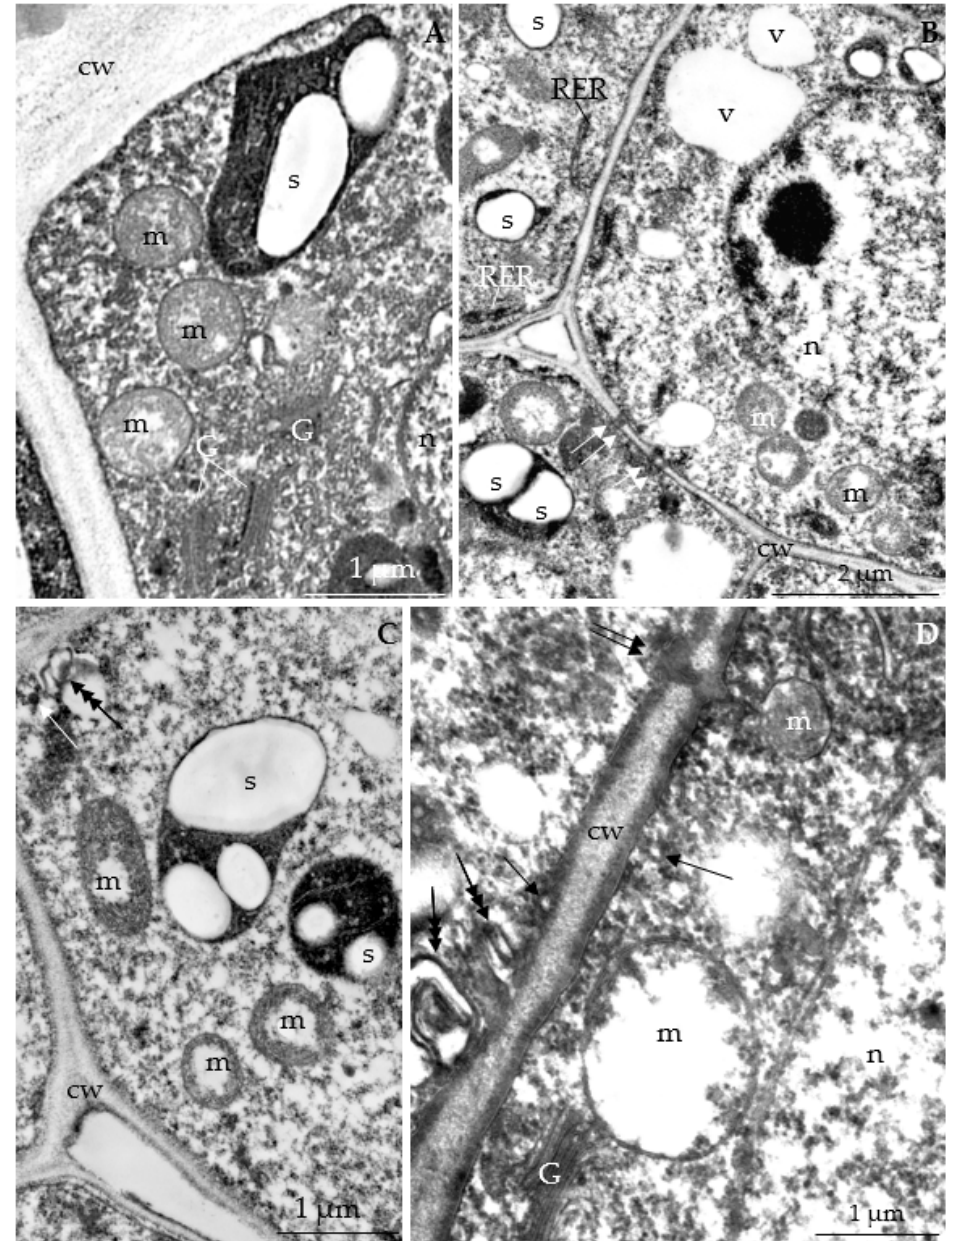
Figure 19. ( A – D ). Fragments of nectary epidermis ( A ) and parenchyma ( B – D ) cells in R. idaeus ‘Polana’ in the initial secretion phase. ( A ): cell wall (cw), plastid with a starch grain (s), Golgi apparatus (G), mitochondria (m), cell nucleus (n). ( B ): plasmodesmata (two arrows), small vacuoles (v), amyloplasts with starch grains (s), mitochondria (m), cell nucleus (n). ( C ): mitochondria (m) located near the wall, amyloplasts with starch grains (s), vesicle fused with the plasmalemma (three-headed arrow), transport vesicles (arrow). ( D ): visible transport vesicles (arrow) visible at the cell wall (cw), plasmodesma (two arrows), vesicle fused with the plasmalemma (three-headed arrow), mitochondrion (m), Golgi apparatus (G), cell nucleus (n).